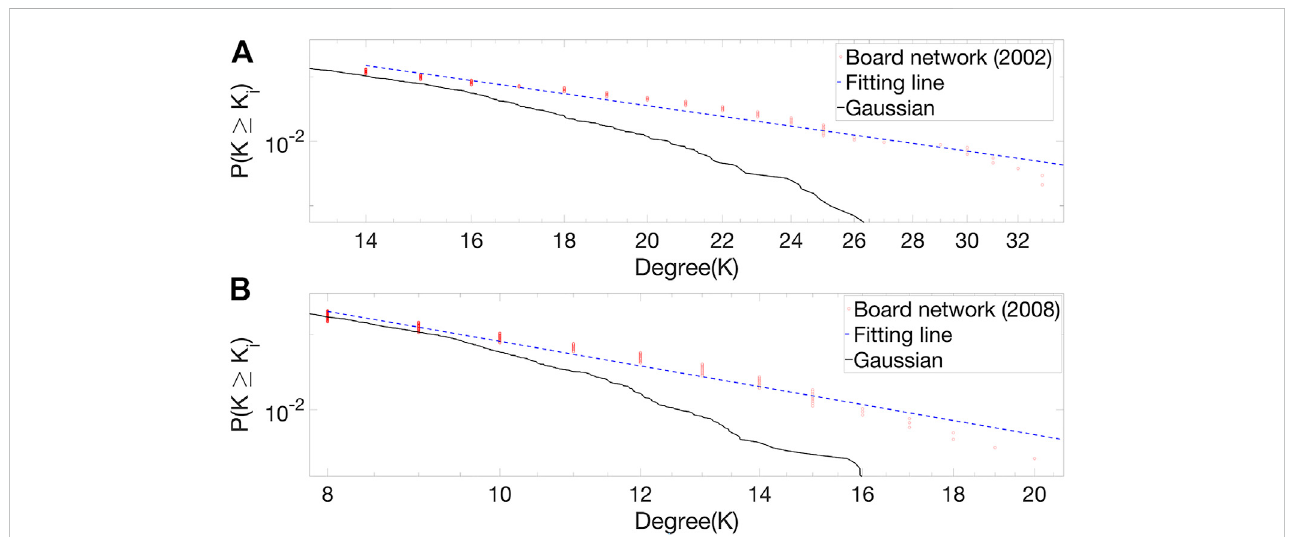
FIGURE 5 Cumulative distribution function (CDF) for the degree of the board network is plotted with a log – log scale. The CDF for the degree distribution of the networkduringtwosubsampleperiods (A) 2002and (B) 2008,theGaussiandistribution,andthe fi tteddatacorrespondtotheredcircle,theblackline,andthe dashed blue lines,